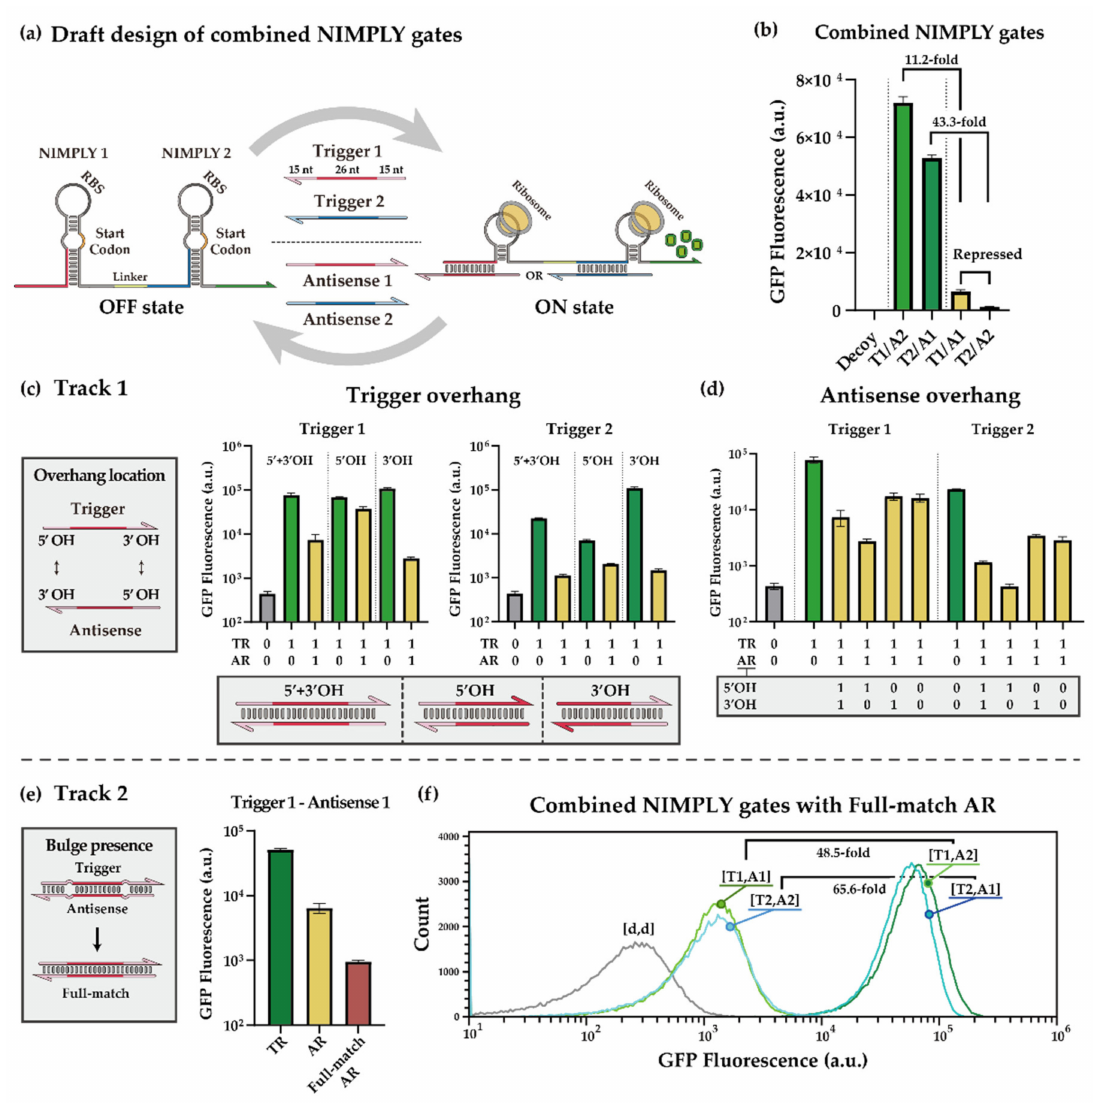
Figure 2. Design of combined NIMPLY gates and optimization strategies. ( a ) Scheme of combined NIMPLY gates composed of two orthogonal NIMPLY gates connected by a 9-nt linker. Trigger and antisense RNAs control the translation states of NIMPLY gates. ( b ) Performance of initial design for combined NIMPLY gates. T1 and T2 denote trigger RNAs that activate NIMPLY gates 1 and 2, respectively, and A1 and A2 denote antisense RNAs that annihilate trigger RNAs 1 and 2, respectively. ( c , d ) Effect of the location of extended overhangs on trigger and antisense RNAs. TR and AR indicate trigger RNA and antisense RNA, respectively. Absence of trigger (TR = 0) indicates that only the NIMPLY gate RNA is present. ( e ) Effect of the presence of bulge on antisense RNA. TR and AR indicate trigger RNA and antisense RNA, respectively. Full match means that no bulge was introduced in the antisense RNA design. ( f ) Flow cytometry GFP fluorescence histograms for the NIMPLY complex with full-match antisense RNAs. T1, T2, A1, and A2 indicate trigger and antisense RNAs for switches 1 and 2 as above, and d represents a decoy RNA that does not interact with the switch RNA. T7 RNA polymerase was induced by 1 mM IPTG in E. coli BL21 DE3 strain. GFP fluorescence was measured on the flow cytometry (error bars indicate ± SD from three biological replicates). Cellular autofluorescence was subtracted in all cases. Autofluorescence level was measured from cells not bearing a GFP-expressing